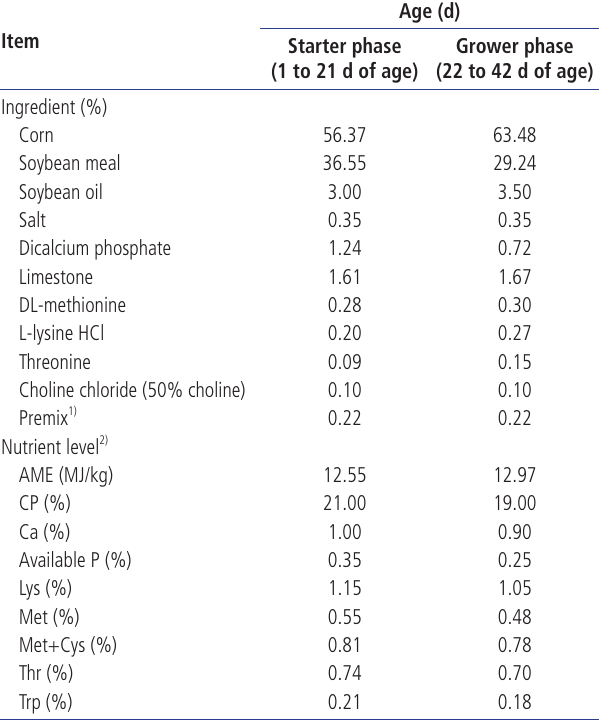
Table 1. Composition and nutrient level of the basal diets